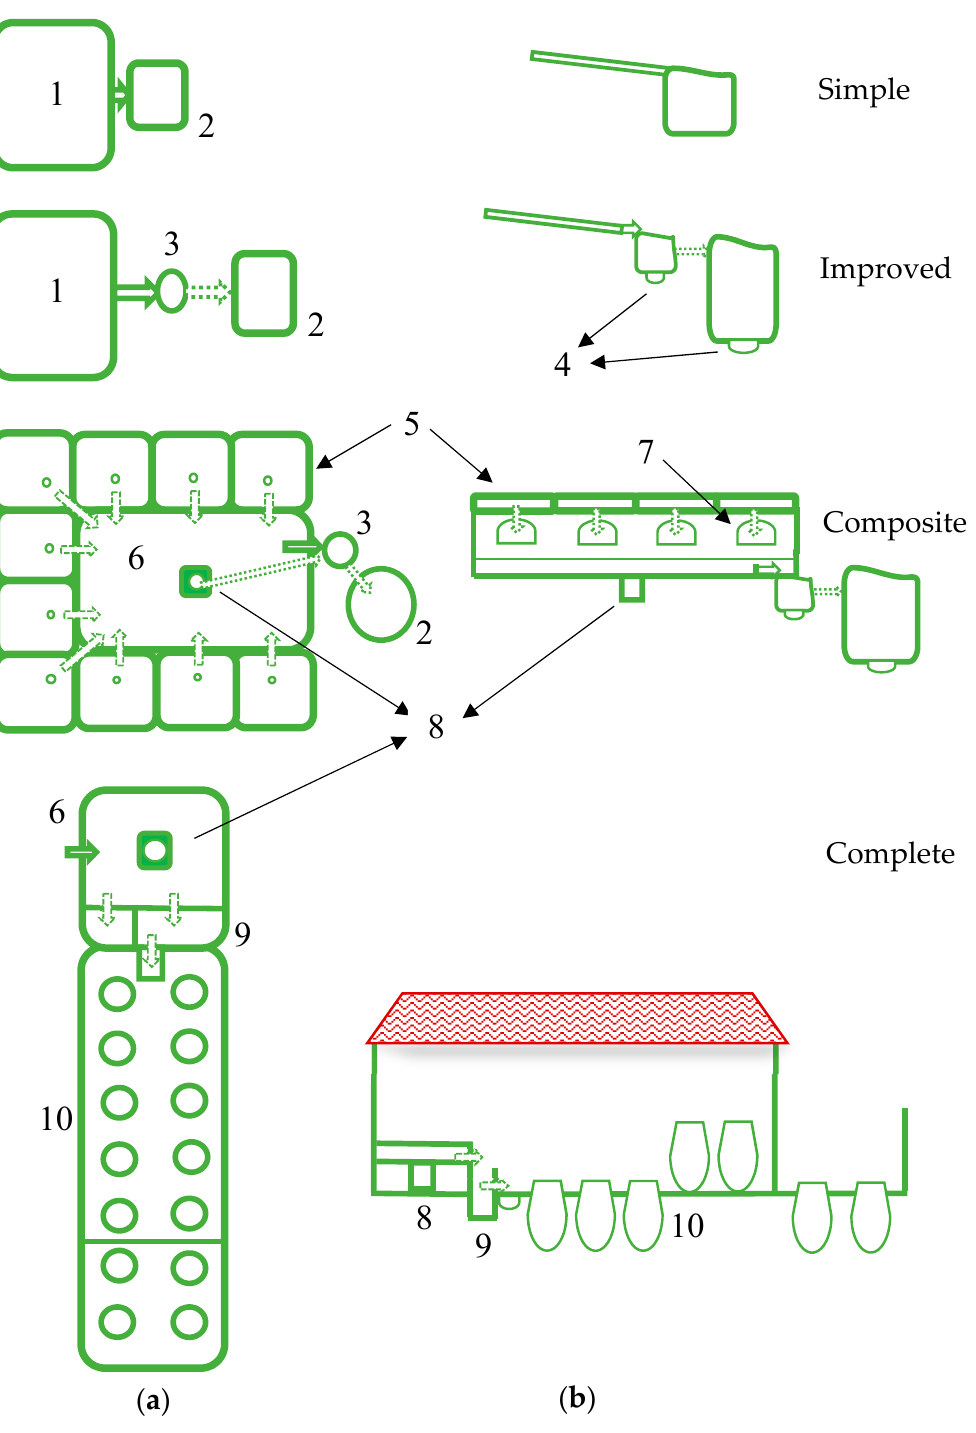
Figure 3. Schematic representation of the various structural typologies of wine production installations: ( a ) , horizontal sections; ( b ) vertical sections) (1, treading floor; 2, juice collecting vat; 3, Intermediate vat; 4, sedimentation pits; 5, grape drying upper floors with holes; 6, treading and pressing floor (in separate sections or not); 7, vaulted compartments; 8, press base; 9, juice collecting vats; 10, clay vessels). Arrows indicate grape or juice flow (solid arrow, surface flow; dashed arrow, channeled flow).